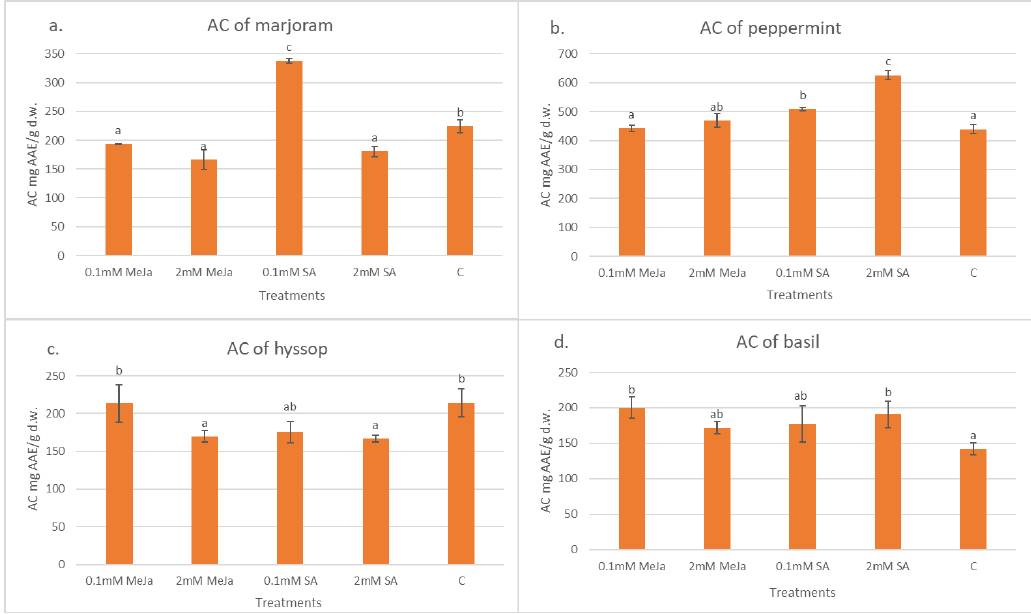
Figure 4. The effect of MeJa and SA on the antioxidant activity of the subject species; ( a ) marjoram, ( b ) peppermint, ( c ) hyssop, and ( d ) basil; Data are expressed as means ± SD; means with different letters are significantly different ( p < 0.05).